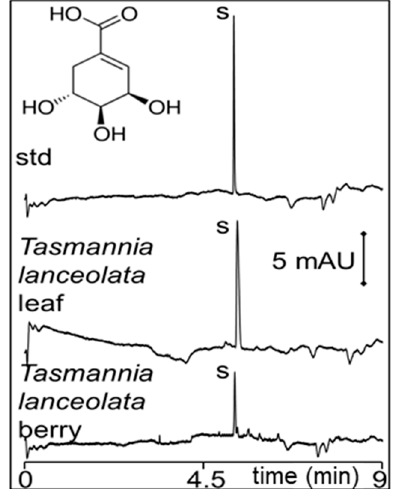
Figure 6. Representative CZE electropherograms of (50 µg/mL) shikimic acid in-house standard (std) and the first PHWE extract with water of Tasmannia lanceolata leaf (1:20 dilution) and berry (1:4